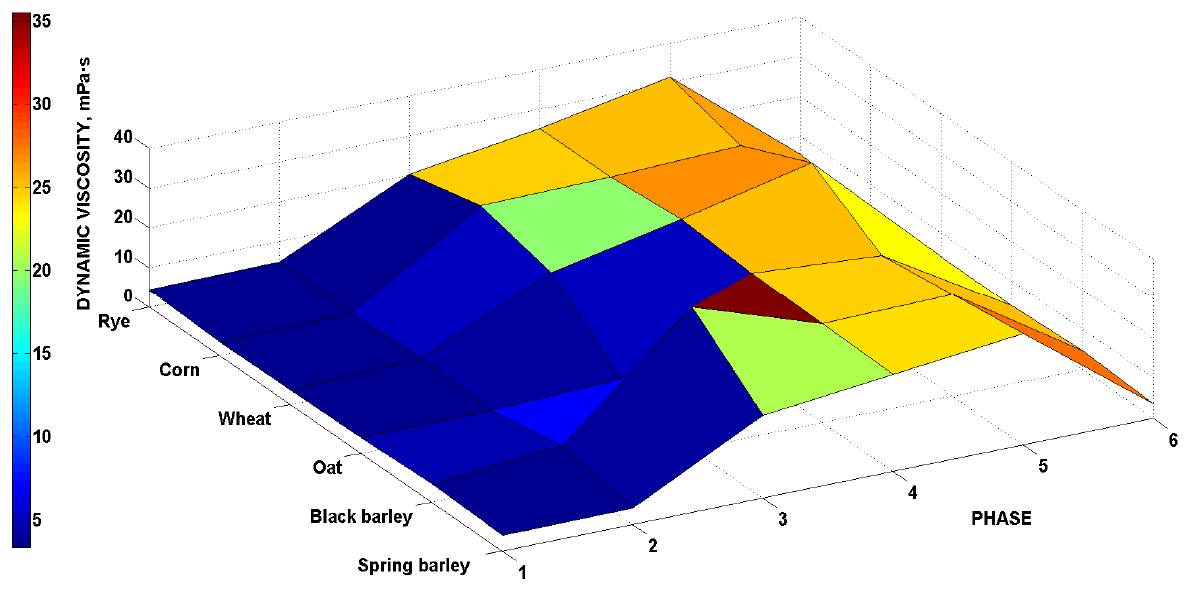
Figure 3. Malts’ viscosity process during the individual phases 1–6.